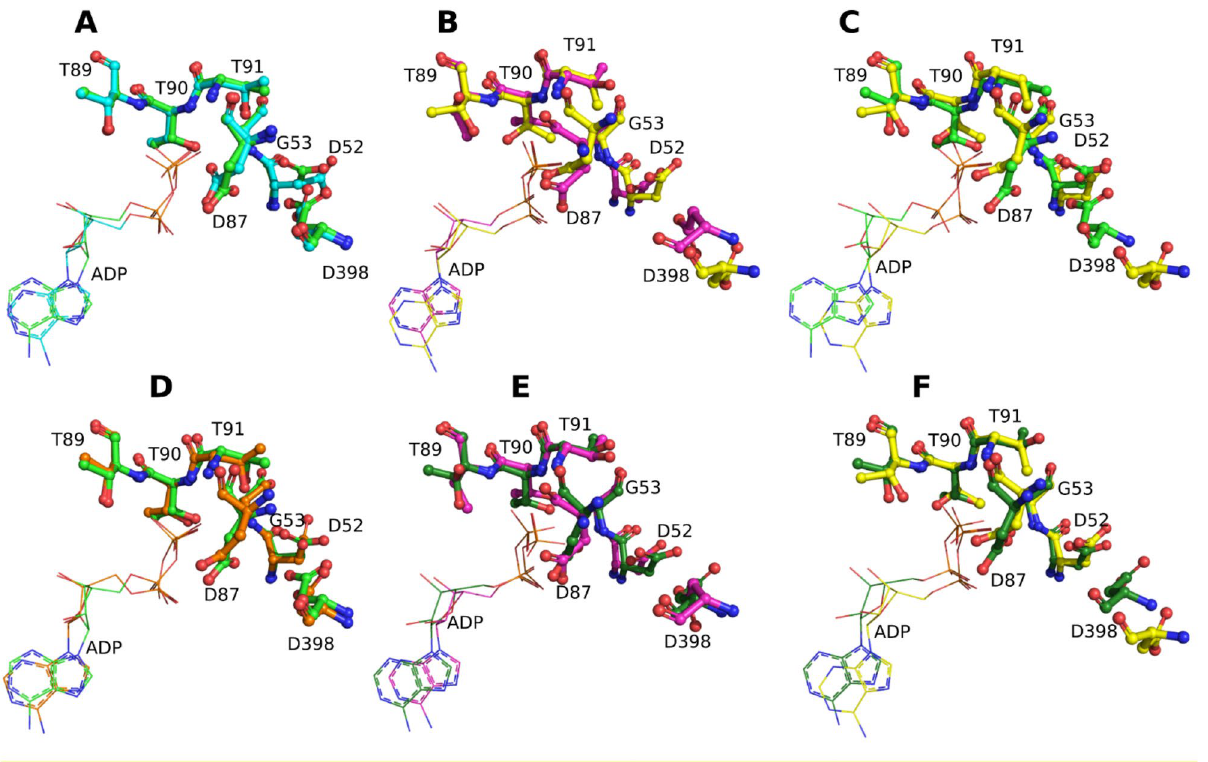
Figure 5. Comparison of the ATP-binding pockets: ( A ) tight cis ring (light green) vs wide cis ring (blue); ( B ) tight trans ring (yellow) vs wide trans ring (magenta); ( C ) tight cis ring (light green) vs tight trans ring (yellow); ( D ) tight cis ring (light green) vs R ′′ ADP-bound-site 4V4O (orange); ( E ) wide trans ring (magenta) vs R-ADP ADP-bound-site 4KI8 (dark green); ( F ) tight trans ring (yellow) vs R-ADP ADP-bound-site 4KI8 (dark green). For additional comparison of tight, wide and R-ADP conformations refer to the Supplementary materials section “Wide and tight conformations of GroEL–ADP14–GroES1 comparison”.